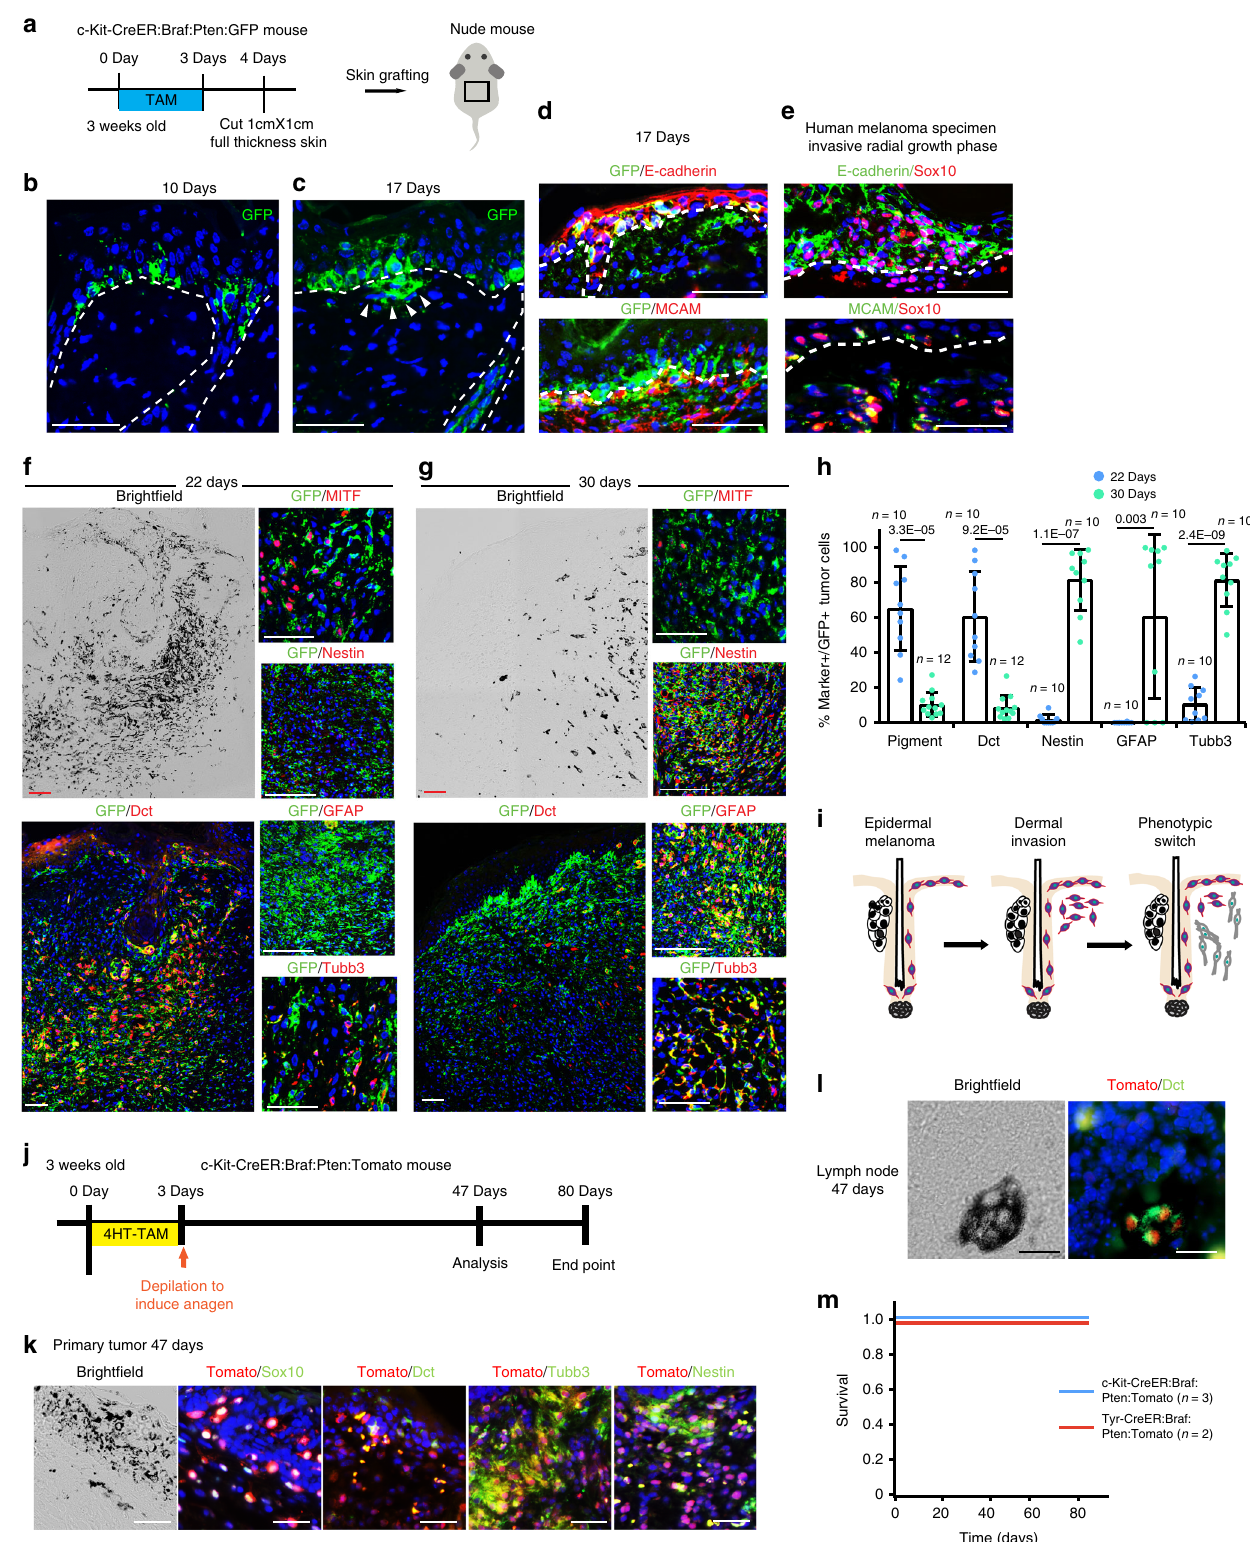
Daysc-Kit-CreER:Braf:Pten:GFP